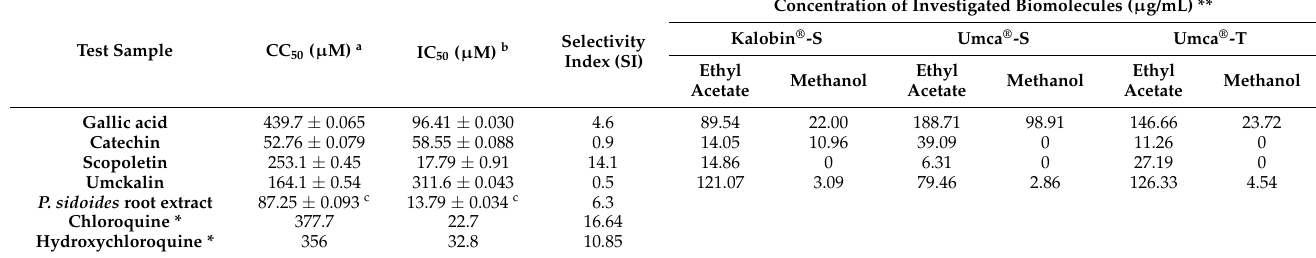
Figure 3. Dose-response curves of the tested compounds: ( a ) Catechin, ( b ) Gallic acid, ( c ) Umckalin, ( d ) Scopoletin, and ( e ) Kalobin extract showing their 50% Cytotoxic concentration on Vero E6 cells (CC 50 ) and their 50% Inhibitory concentration (IC 50 ) against SARS-CoV-2 on Vero E6 cells. Table 3. The 50% cytotoxic concentration (CC 50 ) on normal Vero E6 cells, the 50% inhibitory con- centration (IC 50 ) against SARS-CoV-2-induced cytopathic effect in Vero E6 cells by P. sidoides root extract ± S.E.M., and the assay results of gallic acid, catechin, scopoletin, and umckalin content in Kalobin ® , Umca ® solutions (S) and Umca ® tablets (T).